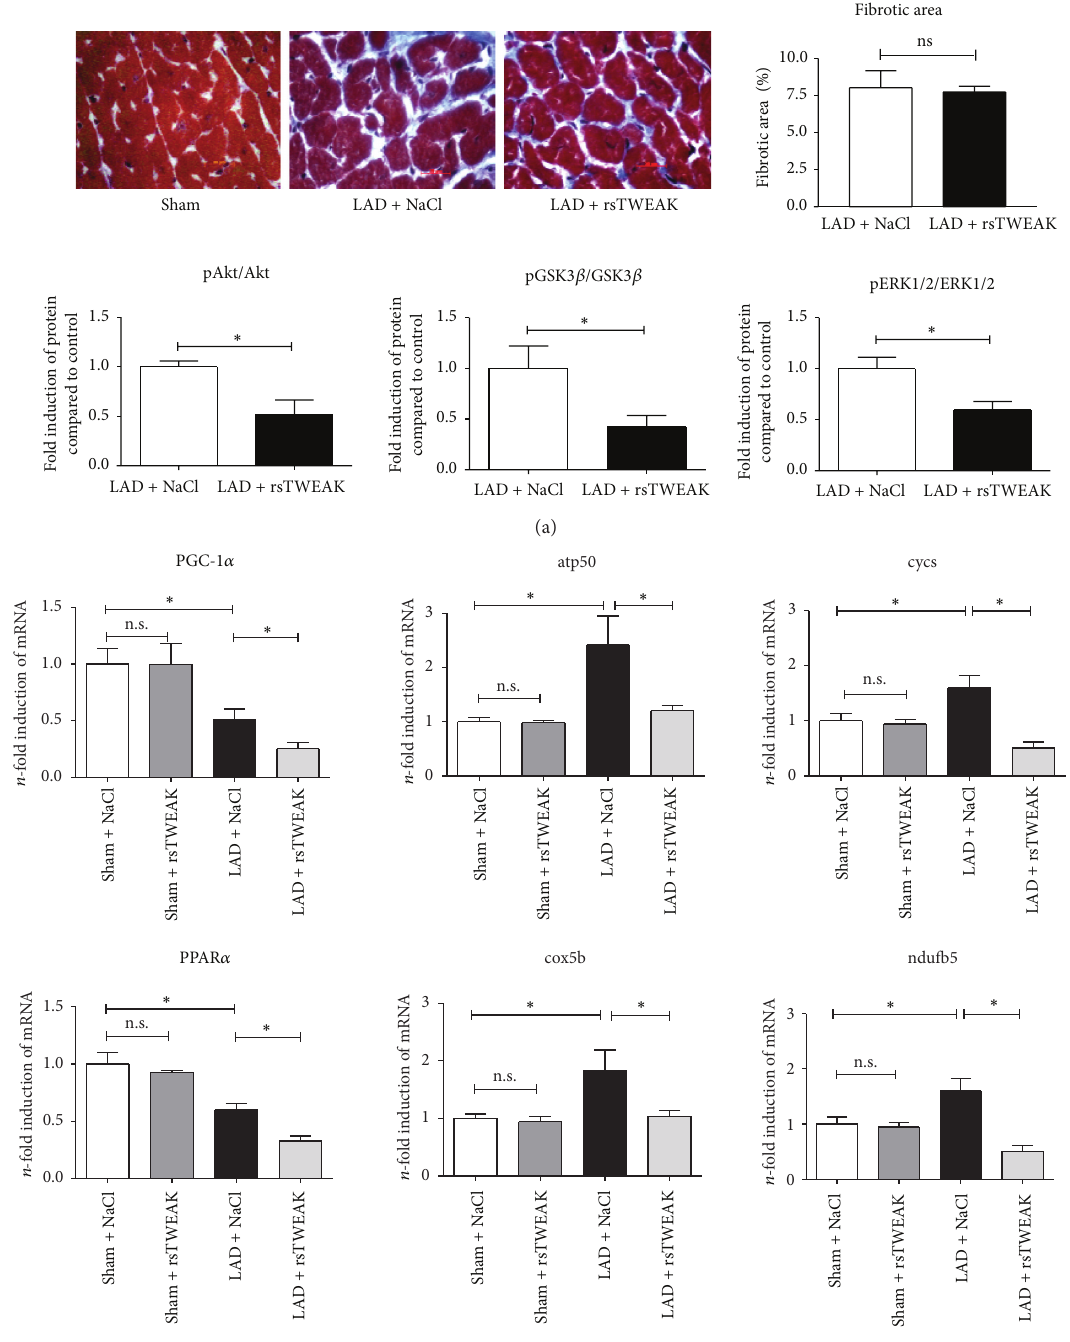
Figure 4: sTWEAK promotes metabolic maladaptation in the remote myocardium after MI. (a) No significant changes in infarct size or interstitial fibrosis were noted in rsTWEAK-treated mice. Phosphorylation of Akt, GSK3 𝛽 , and ERK1/2 was significantly reduced in the myocardiumofTWEAK-treatedanimalscomparedtovehicle-treatedmice( 𝑛 = 5 forNaCLand 𝑛 = 4 forrsTWEAK).(b)PGC-1 𝛼 andPPAR 𝛼 expression in the remote myocardium after MI exhibited greater reductions when mice were treated with rsTWEAK. Likewise, expression of genes involved in oxidative metabolism (OXPHOS) like atp50, cycs, ndufb5, or cox5b was inhibited by treatment of animals with rsTWEAK ( 𝑛 = 5 for sham + NaCL, sham + TWEAK and LAD + NaCL, and LAD +